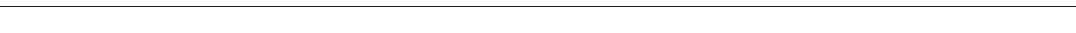
Fig. 2 Read coverage across transcripts and non-poly(A) RNA detection using scRNA-seq methods. a Percentage of sequence read coverage throughout the transcript length. The x -axis shows the absolute distance (bp) from the 3 ′ end of the transcripts ( x i ). The y -axis shows the fraction of transcripts with read coverage ( n i / N i ). n i : the number of transcripts of which at least one read was mapped within the range of ( x i , x i +1 ). N i : the number of transcripts with ≥ x ≥ 1 in rdRNA-seq results and with ≥ 200-bp i transcript length. Only transcripts in the GENCODE (vM9) annotations with transcript per million (TPM) transcript length were considered. PE: data from paired-end reads. b Visualization and comparison of mapped reads of a long transcript, Mdn1 (17 970 bp). We selected Mdn1 as the gene with the highest number of exons (102 exons) in the 25 genes with length ≥ 10 kb and TPM ≥ 5 in rdRNA-seq results. c Distribution of the fraction of exonic regions covered by sequenced reads with 10 pg of RNA data for all transcripts with > 200-bp transcript length in the GENCODE (vM9) annotations. The transcripts were sorted into bins (represented by the number at the top of each panel) according to transcript length. d The sensitivity for detecting histone transcripts using 10-pg RNA samples. Each row represents a histone transcript. Each column represents a sample using the indicated scRNA-seq method. The expression levels in log10 (TPM + 1) quanti fi ed by sail fi sh are indicated according to the color key. e Detection rates of non-poly(A) transcripts (strict criterion) expressed in ESCs for different expression level thresholds in rdRNA-seq. The points and error bars represent means and SDs, respectively. Each line represents a scRNA-seq method. The numbers in parentheses represent the number of